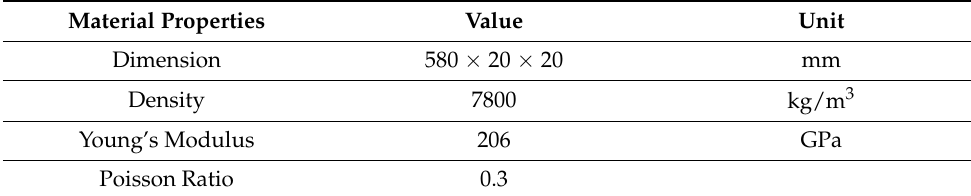
Table 1. FE Settings for Dimensions and material properties of the beam.